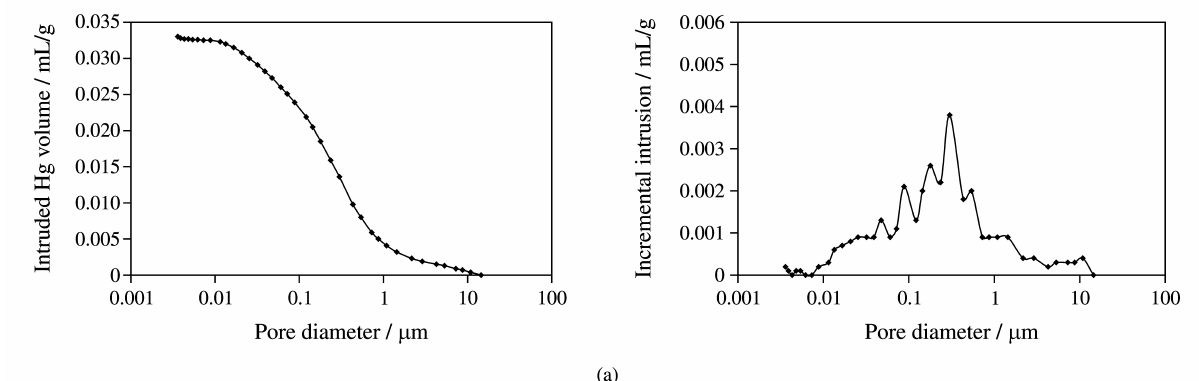
Figure 3. Intruded Hg volume vs. pore diameter curves and incremental intrusion vs. pore diameter curves, obtained from mercury intrusion porosimetry tests of specimens heat-treated at 300 °C: (a) f ck of 20 MPa; (b) f ck of 50